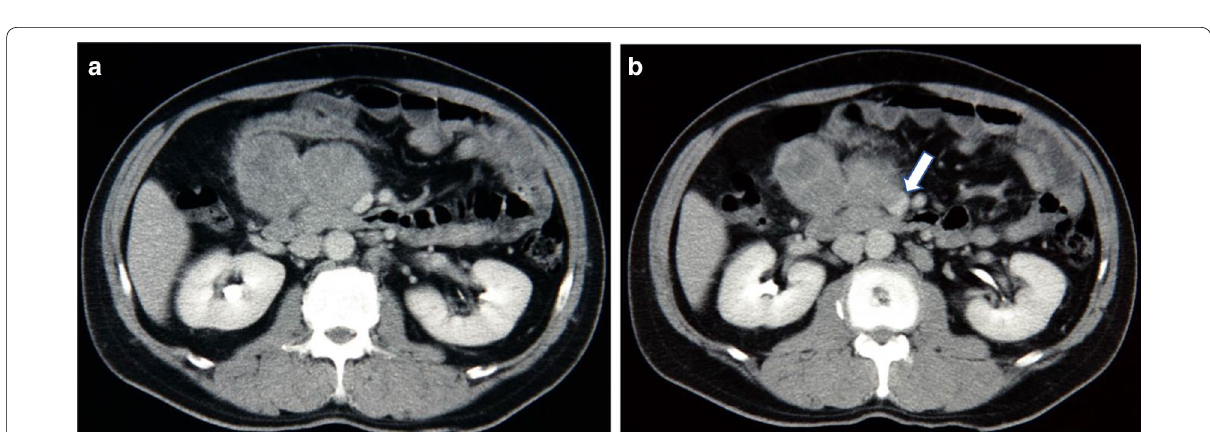
Fig. 2 Abdominal computerized tomography (CT) showing two in‑homogeneously enhanced round contiguous masses, 5 cm in size each, at the region of the pancreatic head ( a ), and the masses invading into the superior mesenteric vein (arrow) ( b